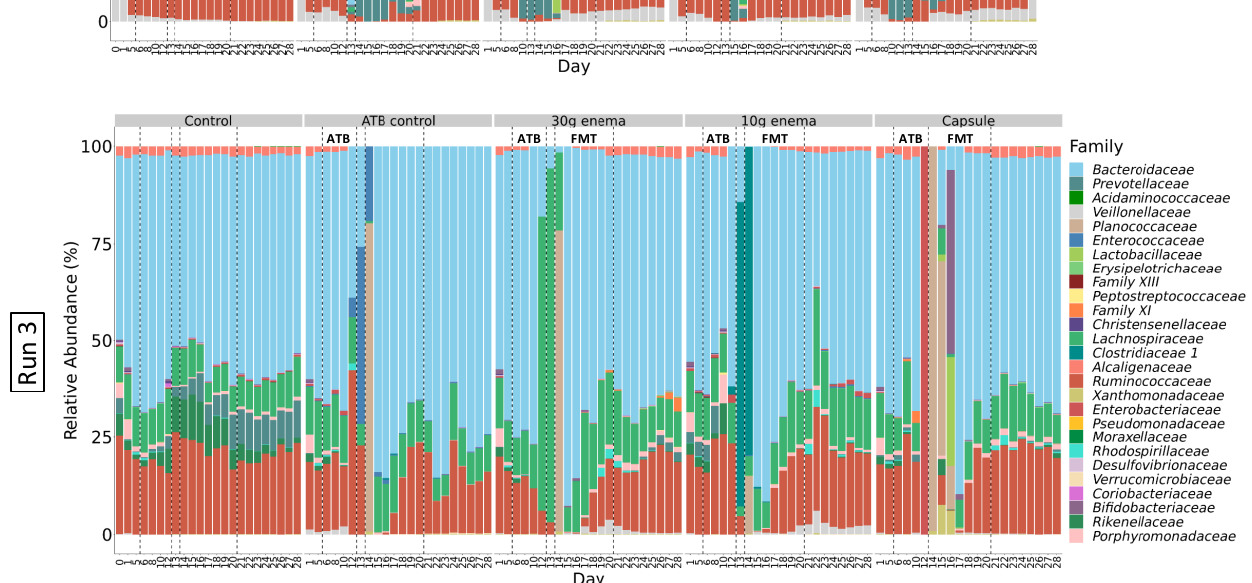
Figure 4. Effect of fecal microbiota transplantation (FMT) treatment on microbial composition at family level. Experiments were performed as described in Figure 1 in triplicate with fecal samples from three healthy adult donors (Run1, Run2 and Run3). Different conditions were ap- plied: no treatment (control), ciprofloxacin (ATB control), ciprofloxacin and 30 g enema, ciprofloxacin and 10 g enema, and ciprofloxacin with oral capsules. Microbial composition was determined at the family level by 16S rRNA gene sequencing and expressed as rela- tive abundances.